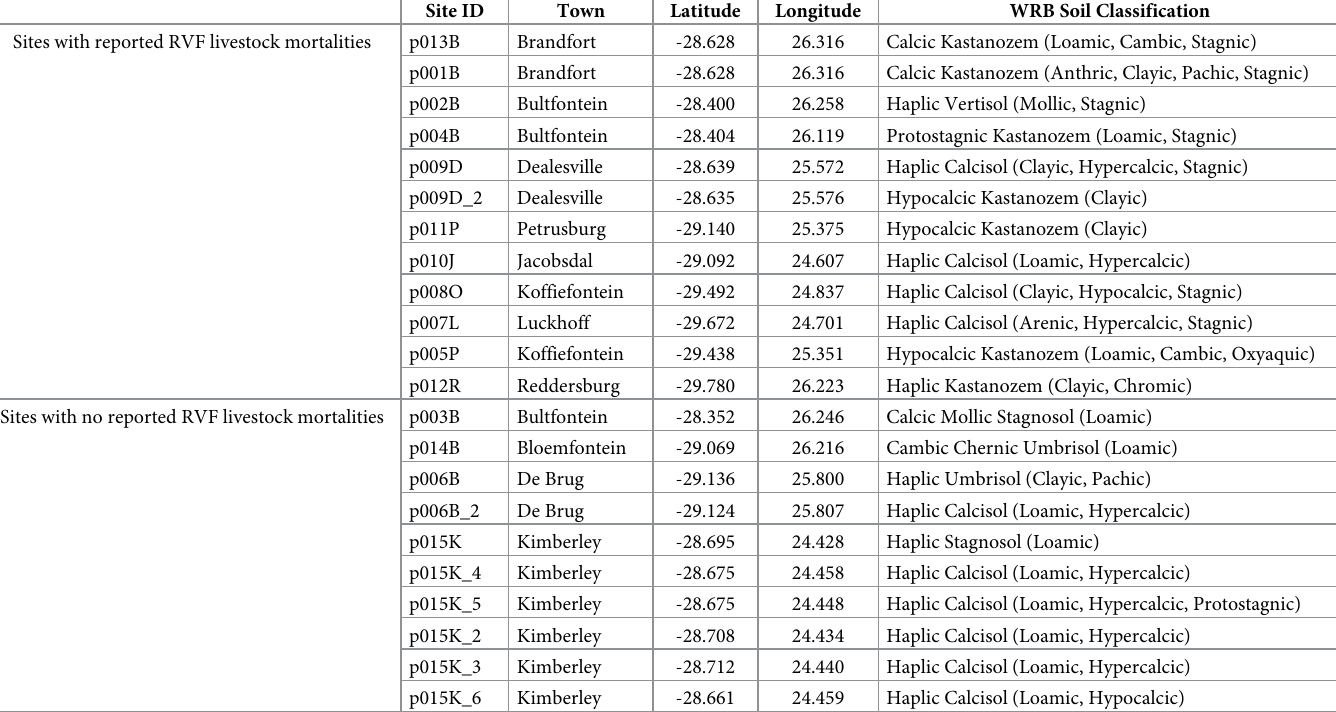
Table 1. Site ID, site name, closest town, coordinates, and World Reference Base (WRB) soil classification [26] of the wetland sites where RVF mortalities have and have not been reported